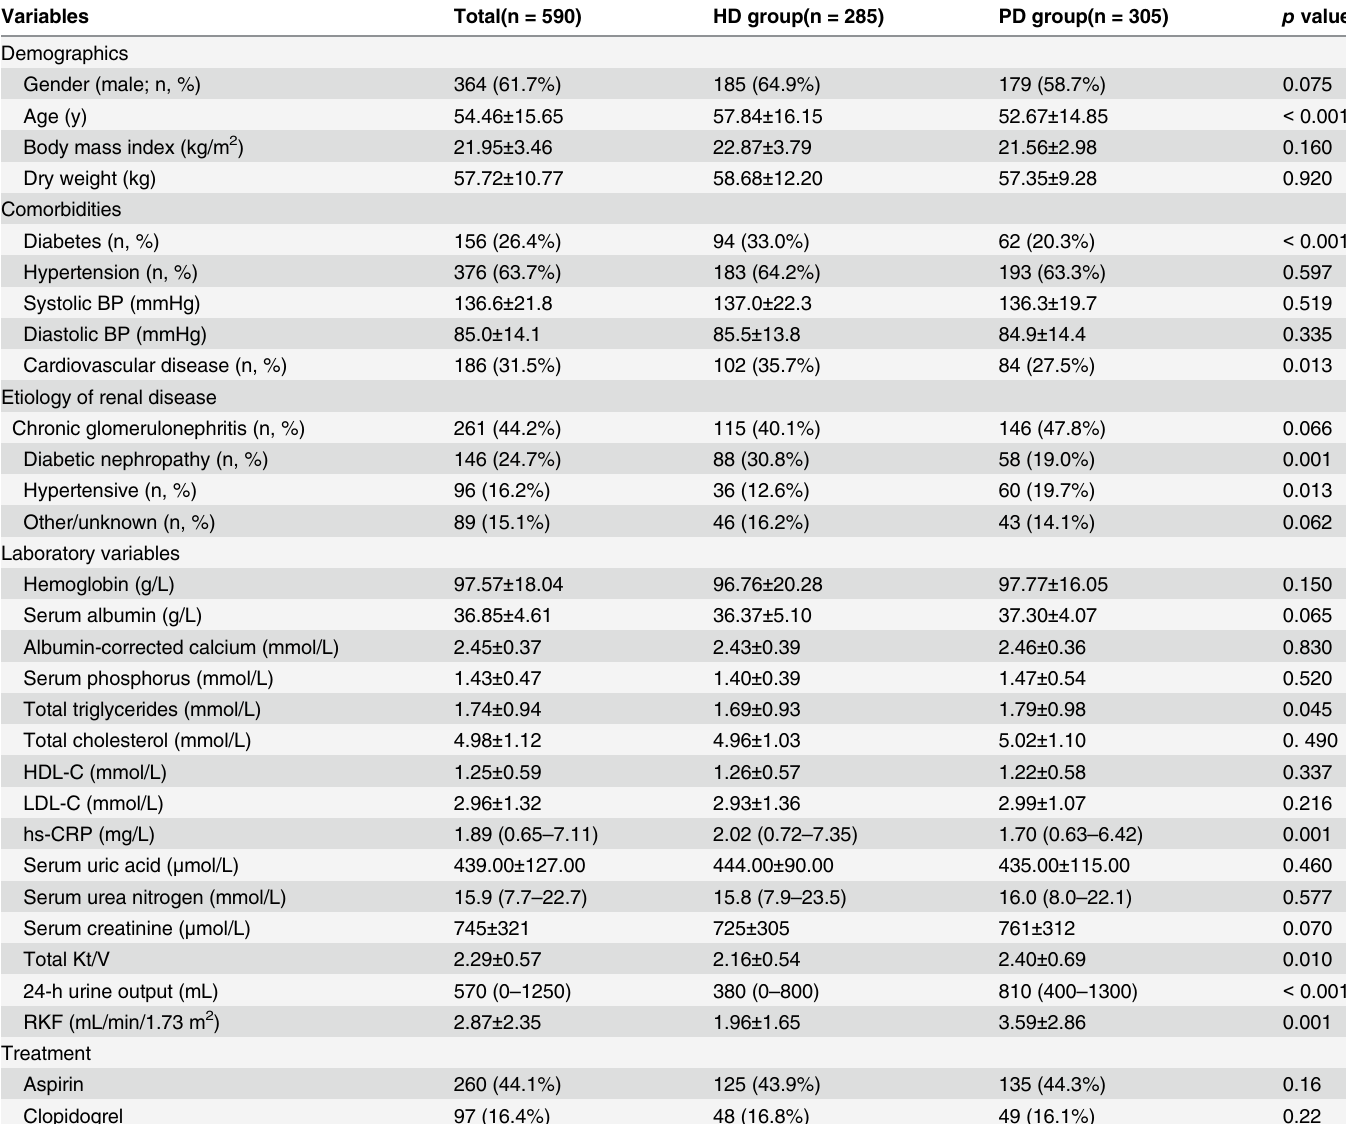
Table 1. Baseline characteristics of dialysis patients.